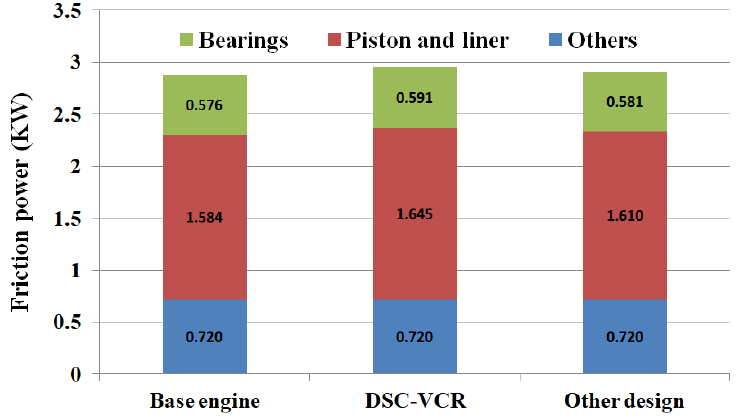
Figure 18. Comparison of engine friction power in case 3.